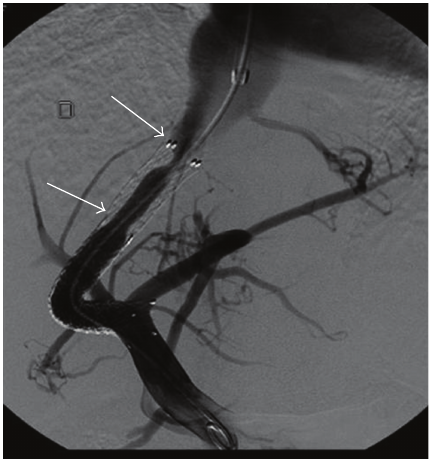
Figure 4: Portography in patient treated one year ago with a TIPS made of a combination of one PTFE-covered stent and one bare stent. Pseudointimal hyperplasia developed only on the bare part of the TIPS (arrows) and induced TIPS